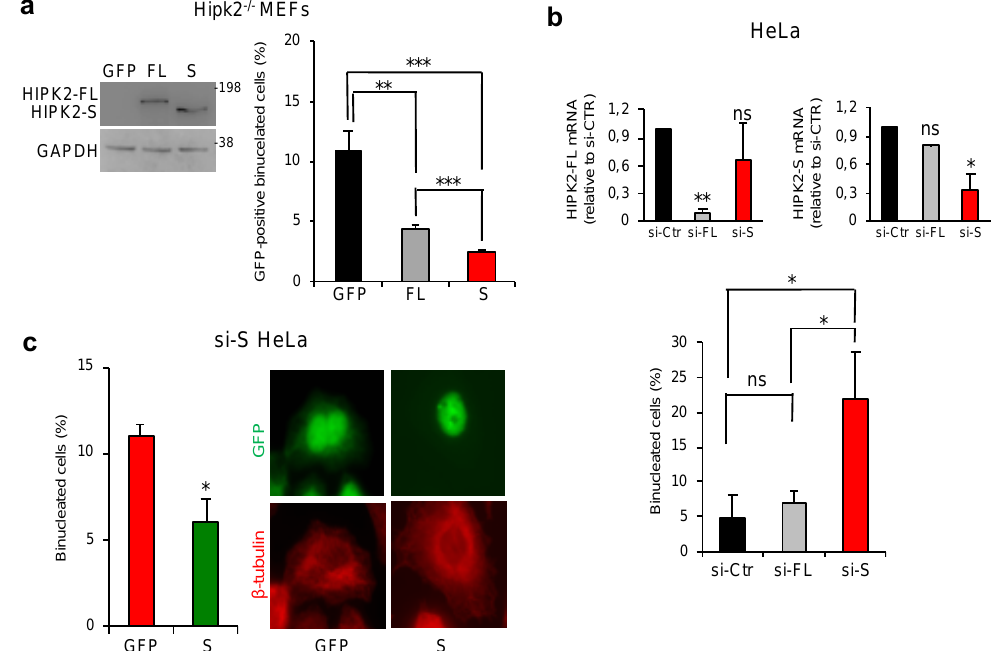
Figure 5. HIPK2-S but not HIPK2-FL is required for successful cytokinesis. ( a ) MEFs from Hipk2 - / - mice were transfected with the GFP empty vector (GFP) the vectors expressing GFP-tagged HIPK2-FL (FL) or HIPK2-S (S) and analyzed 48 h post-transfection for protein expression by WB with anti-GFP Ab. MEFs from the same transfection were maintained in culture for additional 24 h and analyzed for the presence of binucleated cells by GFP autofluorescence, and IF with anti- β -tubulin Ab (red) to mark cytoplasm and DAPI to mark nuclei. The percentage of binucleation was measured in the GFP-positive cells in the three transfected populations (at least total 150 cells per condition were analyzed). Data represent the mean ± SD of three independent experiments. ** P < 0.01; *** P < 0.001. ( b ) HeLa cells were transfected with the indicated stealth siRNAs (see Table S2) and analyzed 72 h post-transfection by qPCR to verify RNA interference and 96 h post-transfection by IF after staining with DAPI and anti- β -tubulin Ab to visualize cytoplasm and score binucleated cells (at least 300 cells in total per condition were analyzed) as shown in ( a ). Values are mean ± SD of three independent experiments. * p < 0.05 and ** p < 0.001, t-test relative to si-Ctr (in left panels). ( c ) HIPK2-S depleted cells (si-S) were obtained as in ( b ), transfected with GFP or GFP-HIPK2-S 48 h post-siRNA transfection and analyzed by IF as in ( b ). Note that in si-S cells the expression of GFP-HIPK2-S is not inhibited by RNAi because the employed siRNAs recognize sequences that are not present in the GFP-HIPK2-S expressing vector (i.e., downstream HIPK2-S stop codon; Figure 1a). The percentage of binucleated cells relative to the GFP-positive cells is reported as mean ± SD of two independent experiments, in which at least total 200 cells per condition were analyzed. * p < 0.05. Representative images are